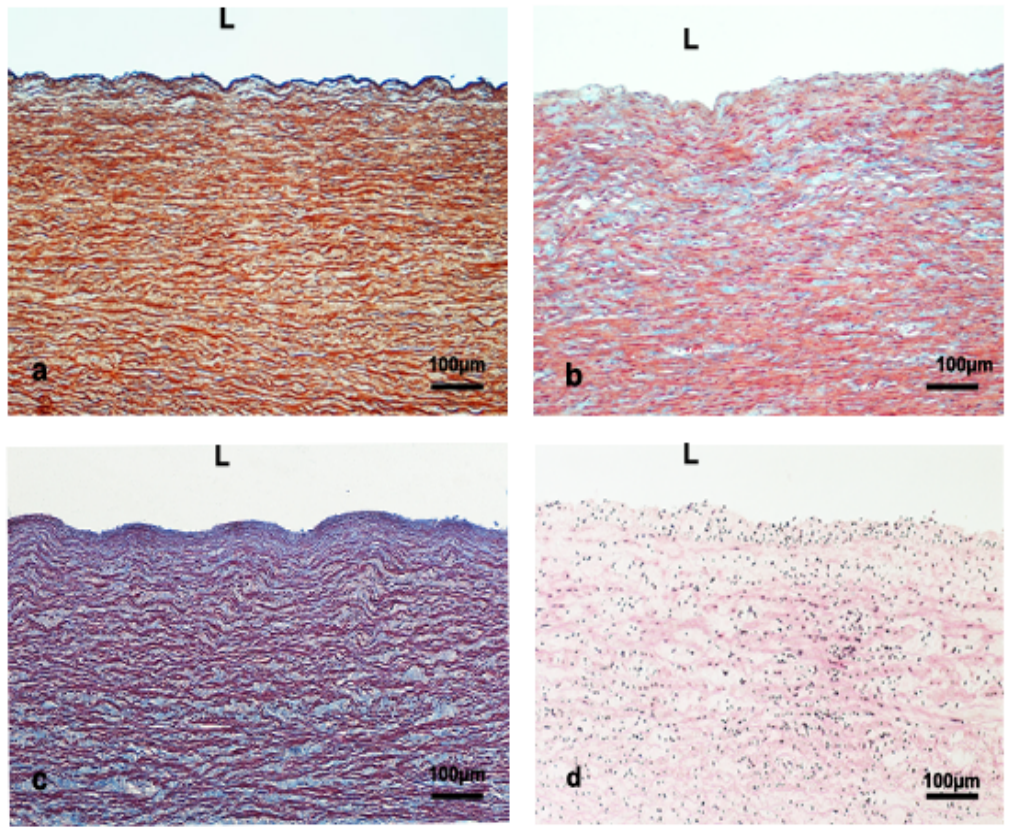
Figure 3. Thoracic aorta sections, ( a ) juvenile male Grampus griseus (orcein staining), ( b ) juvenile male Kogia breviceps (trichromic staining), ( c ) subadult male Physeter macrocephalus (orcein staining), and ( d ) adult male Mesoplodon densirostris (hematoxylin/eosin). Elastic fibers; (dark brown) in ( a ) and violet ( c ) and orange in ( b ). Connective tissue: blue in ( b , c ), light brown in ( a ). L; lumen. Elastic laminas are mainly circular oriented.